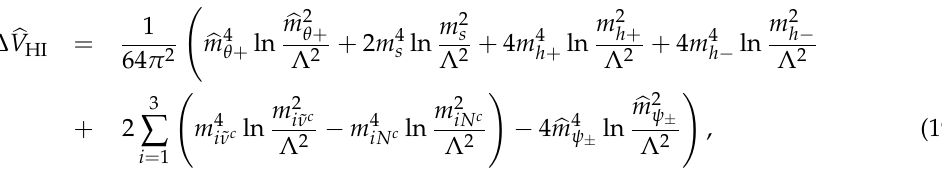
Table 3. The mass squared spectrum of our models along the inflationary trajectory in Equation (8) for K = K 1 , K 2 , K 3 and φ 1. To avoid very lengthy formulas, we neglect terms proportional to M (cid:28) Masses Squared Fields Eigenstates K = K 1 K = K 2 K = K 3 14